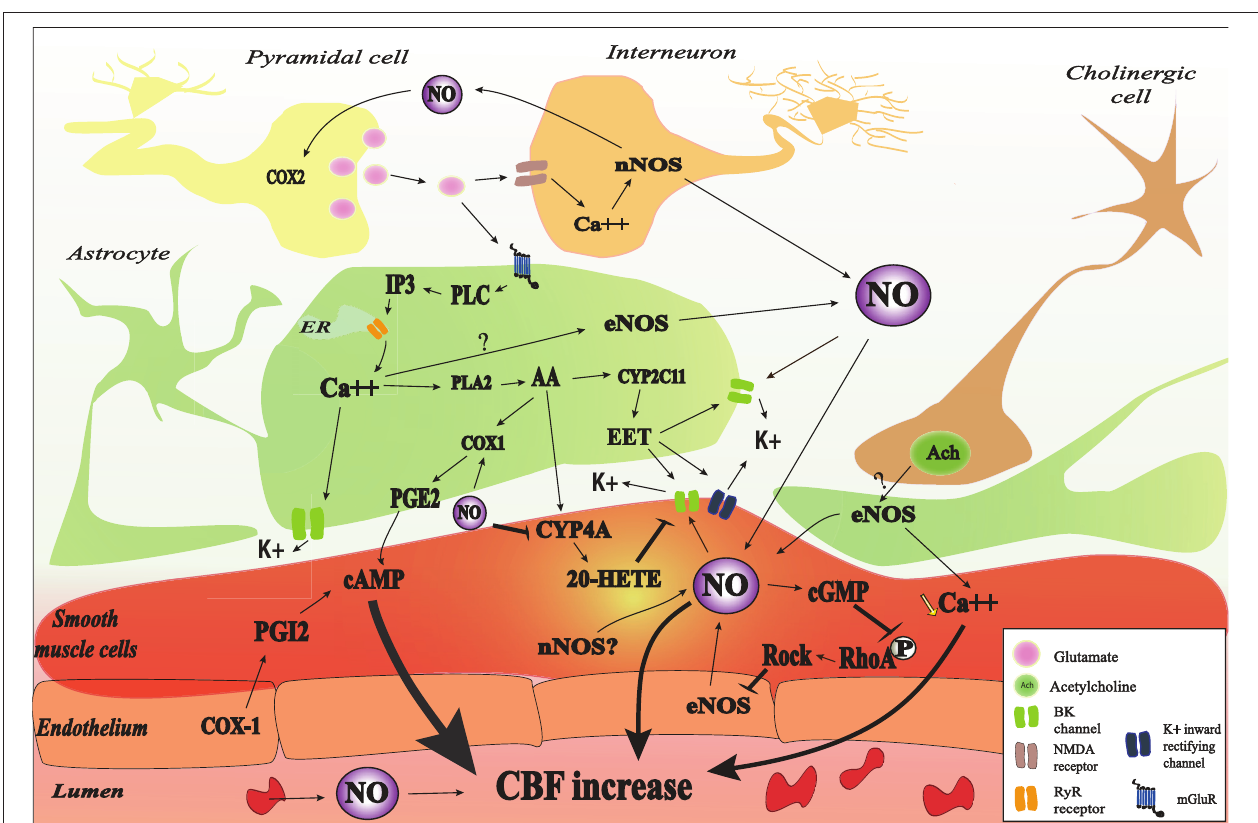
FIGURE 1 | Nitric oxide (NO) interactions in neurovascular coupling (NVC). NO may be released from red blood cells, endothelial cells, smooth muscle cells, astrocyte, interneurons, and some pyramidal cells. NO may be involved in the initiation of NVC through a cyclic guanosine monophosphate (cGMP)-dependent pathway and may modulate NVC probably by interaction with different cGMP-independent pathways. In astrocyte, glutamate released from pyramidal cell binds to the metabotropic glutamate receptor (mGluR) which lead to IP 3 formation and the subsequent release of Ca 2 + . The increase in intracellular Ca 2 + activates BK channel and catalyses the phosphorylation of arachidonic acid (AA) by phospholipase A 2 (PLA 2 ). AA metabolites (PGE2, 20-HETE, and EET) will mediate cerebral blood flow (CBF) through different pathways. NO may interact with different astrocytic